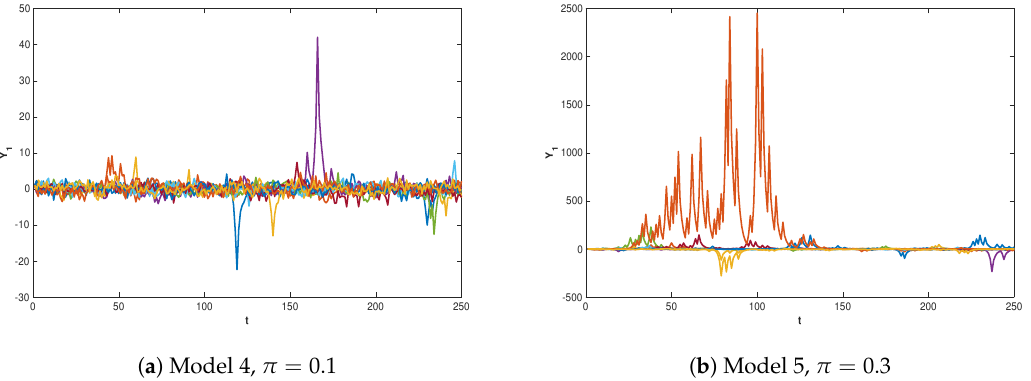
Figure 4. Simulated paths of Y 1 t of model in Equation (1) represented by different colors with parameters from models 4 and 5 for over n = 250 period, where (cid:101) t ∈ N { 0,1 } The parameters are those from Table 1 and the probability to be in the explosive regime 2 is equal to π